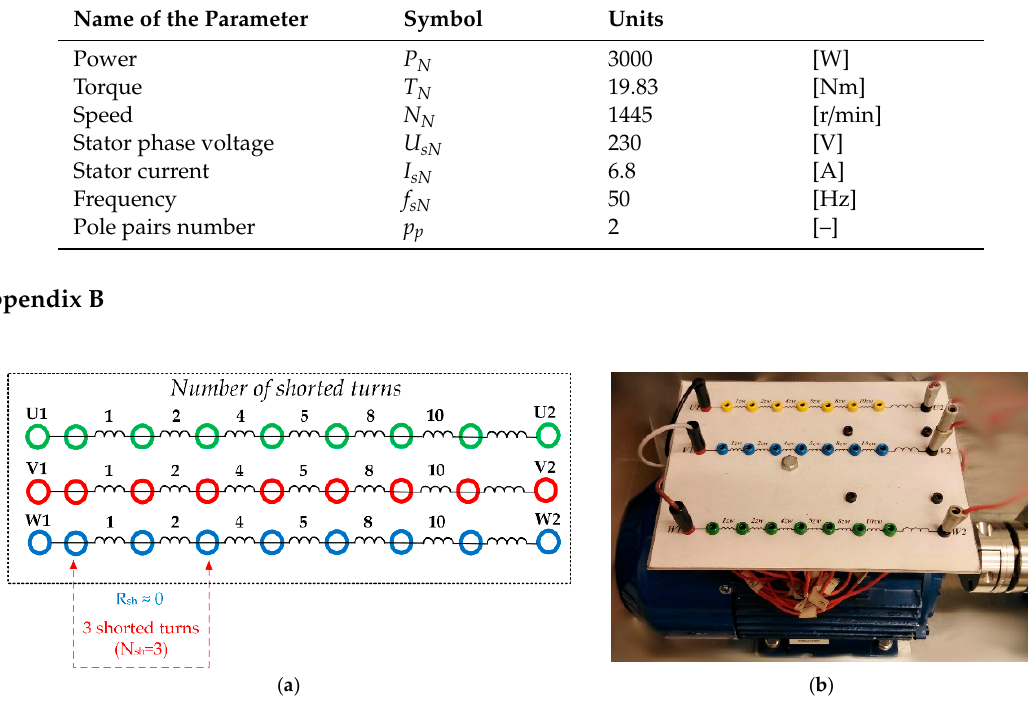
Figure A1. Illustration of the physical modelling of stator fault: ( a ) connection of the stator winding for inter-turn short-circuit modelling; ( b ) tested induction motor—real view.